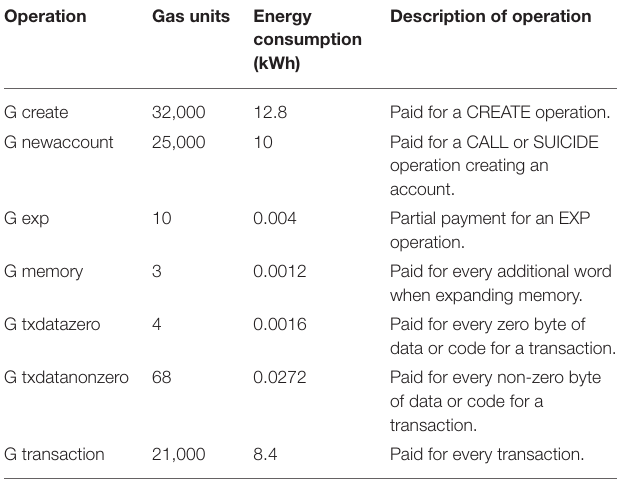
TABLE 2 | Energy consumption of different specific smart contract operations [based on Wood (2017) and Hurwitz (2019)].